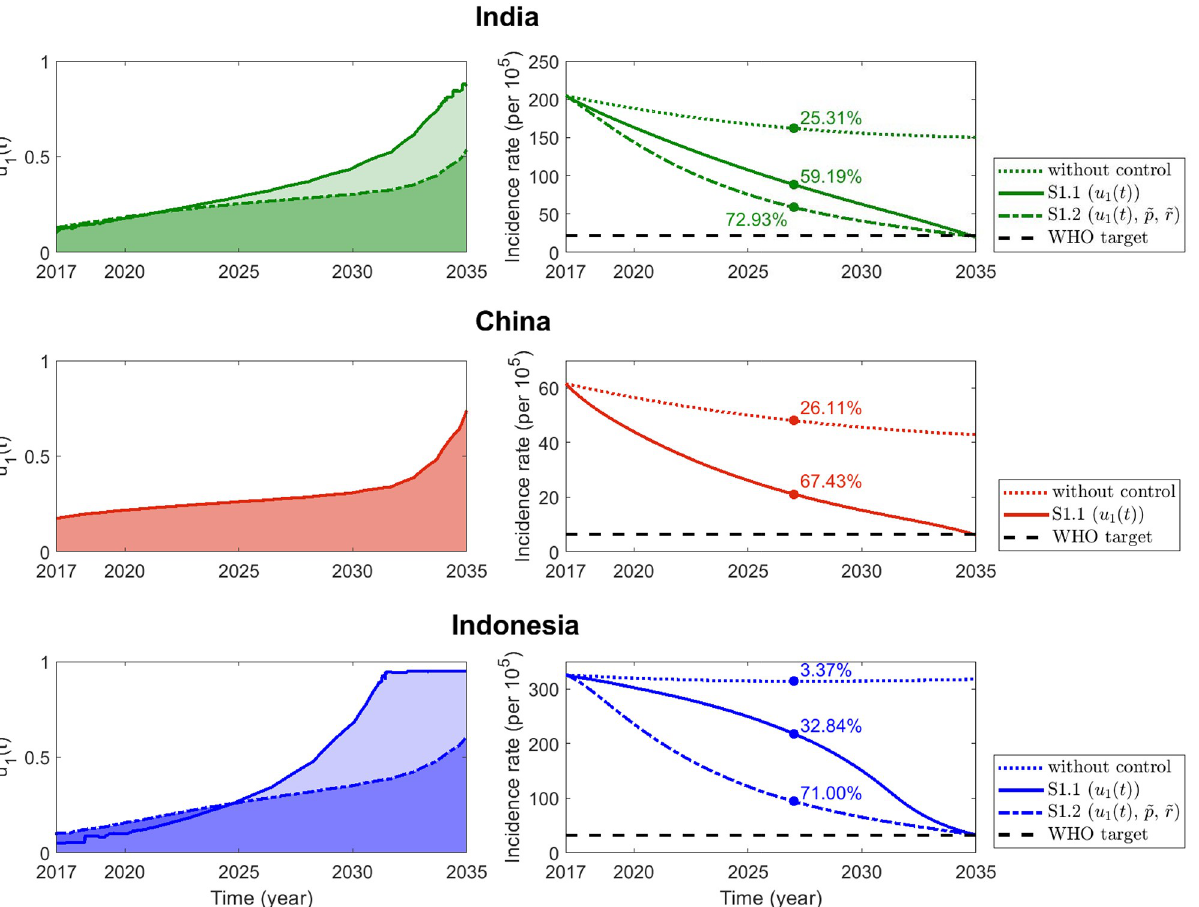
Fig 6. Scenario 1: Nonpharmaceutical control strategy. Optimal control strategies with constant case holding and active case finding controls (dash- dotted) or without the two constant controls (solid) are displayed as functions of time, in the frames on the left. The frames on the right present the corresponding incidence rates and the WHO targets in 2035 (black dashed